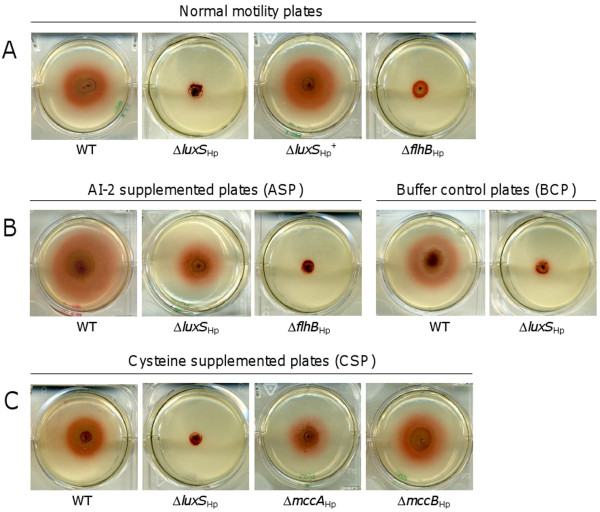
AI-2, but not cysteine rescues the motility defect of the ΔLuxSHp mutant. (A) Wild-type, ΔluxSHp, and ΔluxSHp+ bacteria were seeded onto soft plates composed of normal medium. The non-motile ΔflhB mutant served as the negative control. (B) Wild-type, ΔluxSHp and ΔflhBHp bacteria were seeded onto motility plates supplemented with in vitro synthesised AI-2. Wild-type and ΔluxSHp were also seeded on motility plates containing buffer control solution used for in vitro AI-2 synthesis. (C) Wild-type, ΔluxSHp ΔmccAHp and ΔmccBHp strains were seeded onto chemically defined motility plates supplemented with cysteine. After 5 days of incubation, the motility halo of each strain on each plate was recorded using a digital camera and the area of each halo was measured using a GS-800 Calibrated Densitometer (Biorad).